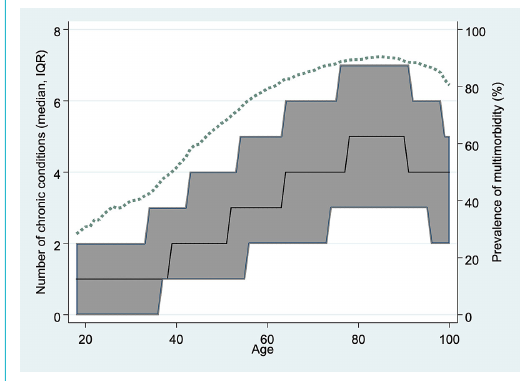
Figure 2: Age-dependent median number of chronic conditions (n, interquartile range [IQR]) and prevalence of multimorbidity (dashed line) on a continuous age scale.